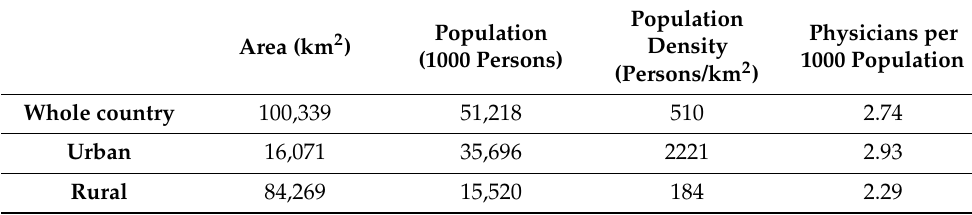
Table 1. A comparison of basic information between urban and rural populations for 2016. Population Area (km 2 ) (1000